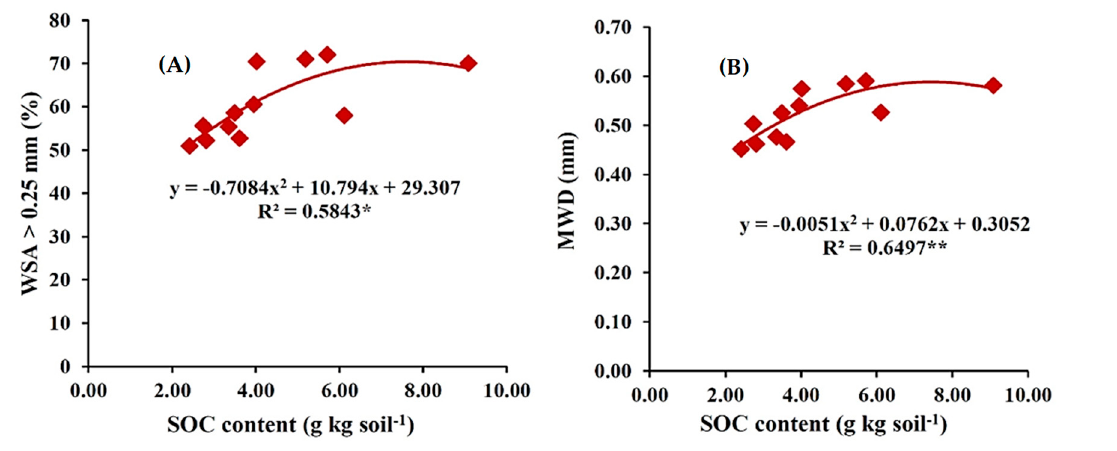
Figure 2. Relationship of ( A ) water-stable aggregates (WSA) > 0.25 mm (%) and ( B ) mean weighted diameter (MWD) (mm) with soil organic carbon (SOC) (g kg soil − 1 ) irrespective of land uses and depths. * and ** next to R 2 values indicate significance at p ≤ 0.05 and p ≤ 0.01 respectively.